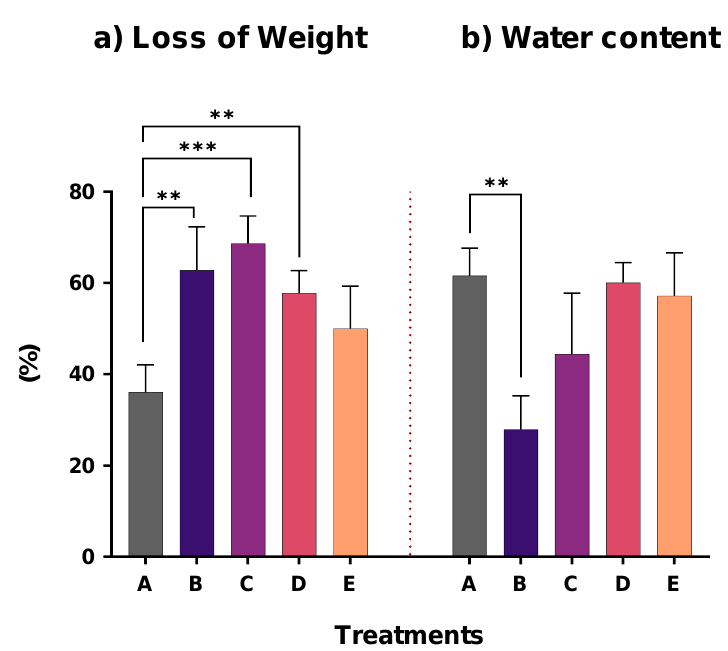
Figure 2. Loss of weight and water content at the end of the experiment for all treatments (star indicates the level of significance: ** for p < 0.01, *** for p < 0.001).